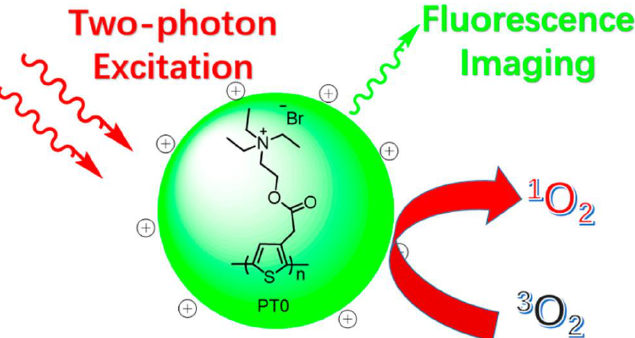
Figure 16. Illustration of PT0 for simultaneous two-photon excitation fluorescence imaging and photodynamic therapy. Reproduced with permission from reference [127]. Copyright 2017, American Chemical Society.